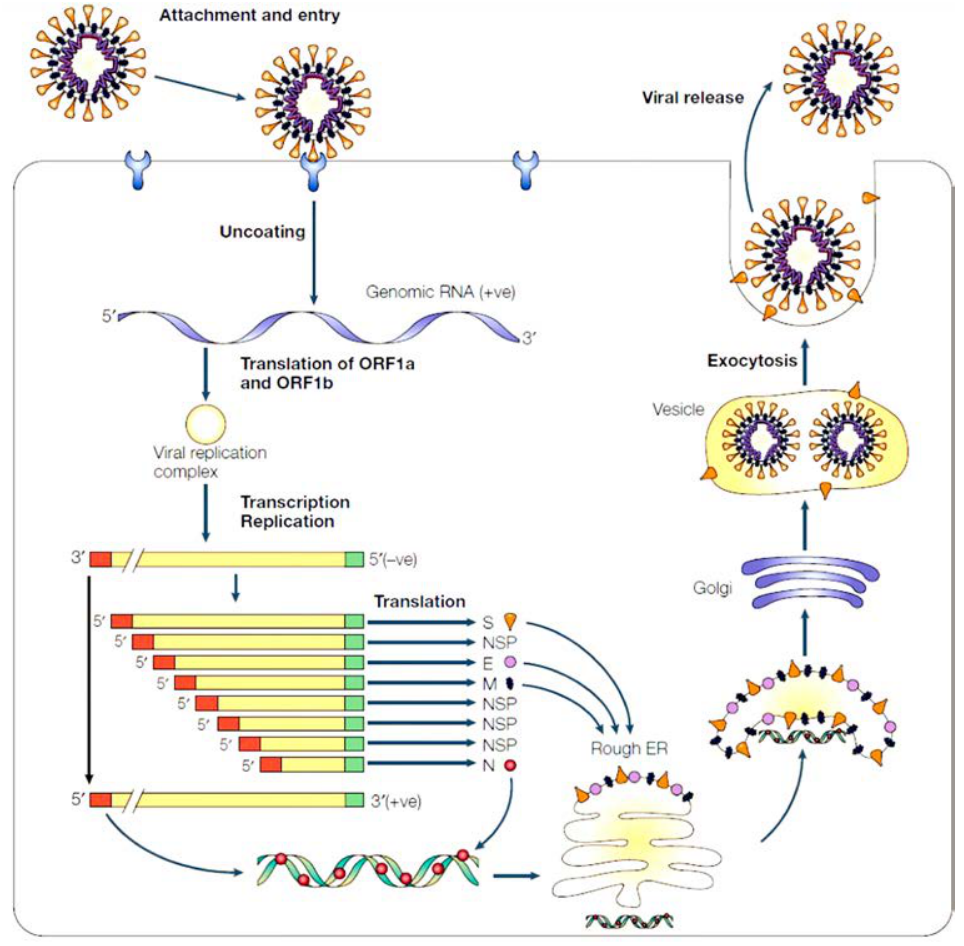
Fig. 5. Schematic diagram of coronavirus replication inside the cell Reproduced with permission from